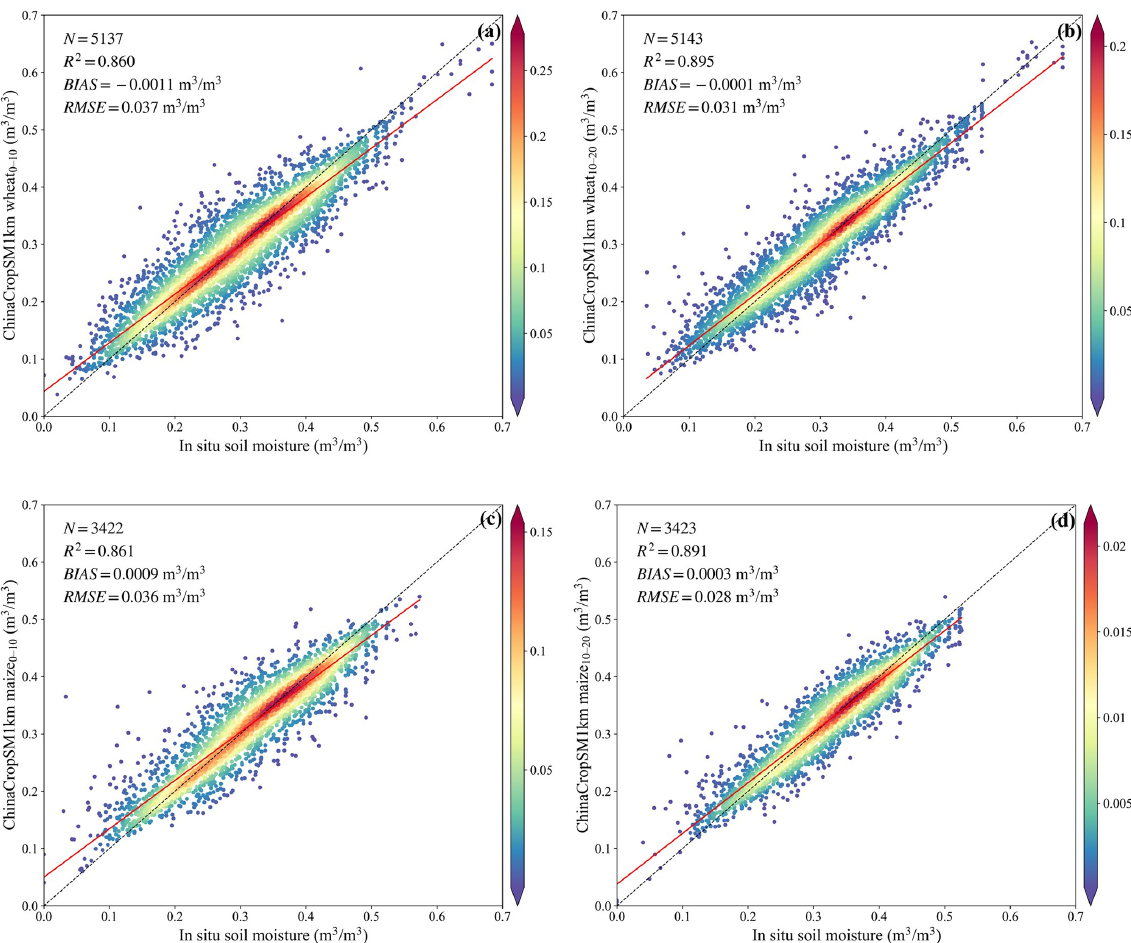
Figure 3. Comparison between the predicted soil moisture (ChinaCropSM1 km) and in situ samples by crops and depths (cm). (a) wheat 0–10 , (b) wheat 10–20 , (c) maize 0–10 and (d) maize 10–20 . The red lines are the trend lines, the color bar indicates the point density, and the black lines represent the 1 : 1 lines.